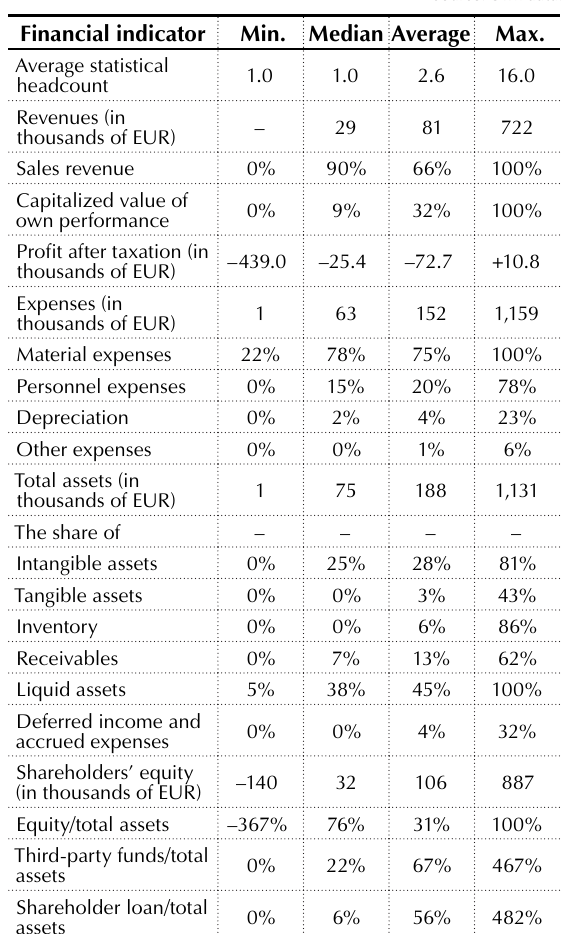
Table 1. Main indicators applied in our sample